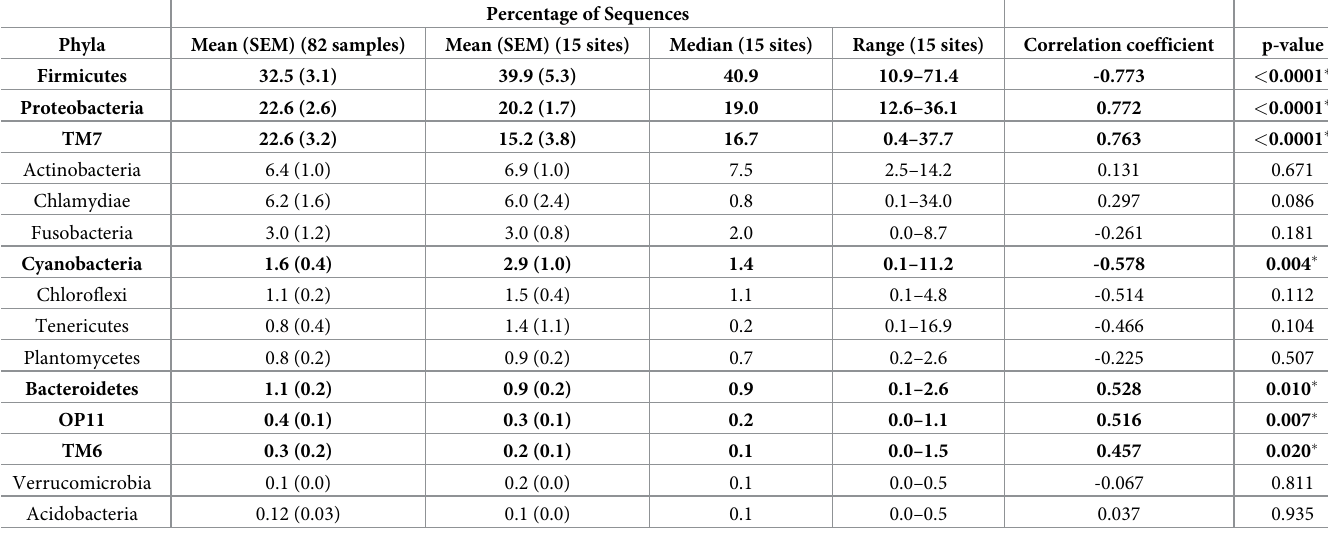
Table 1. Individual and site average relative abundance of dominant phyla and correlations to landscape